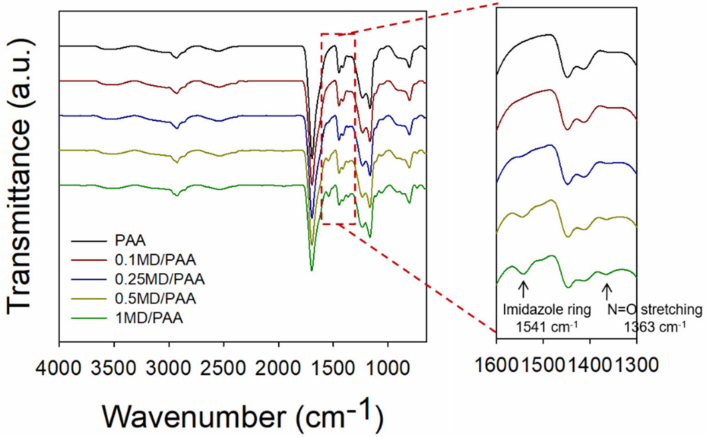
Figure 5. FTIR spectra of MD / PAA (metronidazole / poly (acrylic acid)) hydrogel films with di ff erent content of MD (0, 0.1, 0.25, and 0.5 wt%) and radiation dose at 25